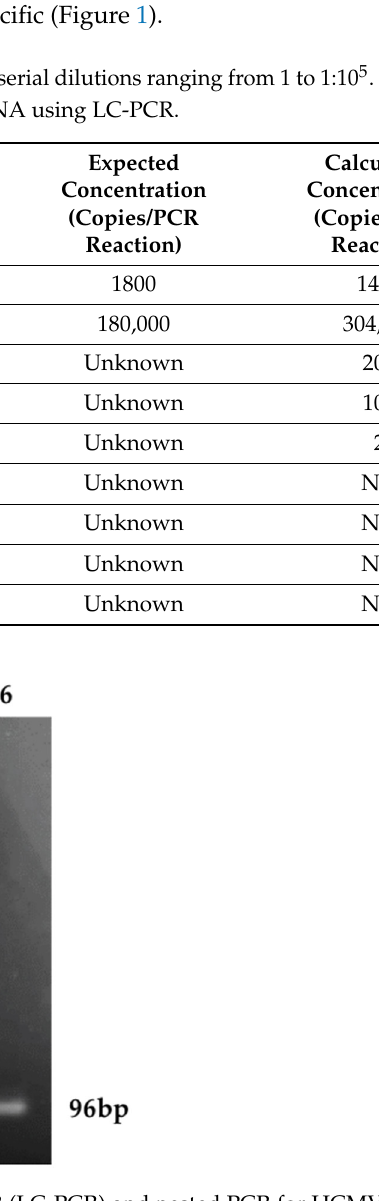
Figure 1. The detection limit of LightCycler PCR (LC-PCR) and nested PCR for HCMV